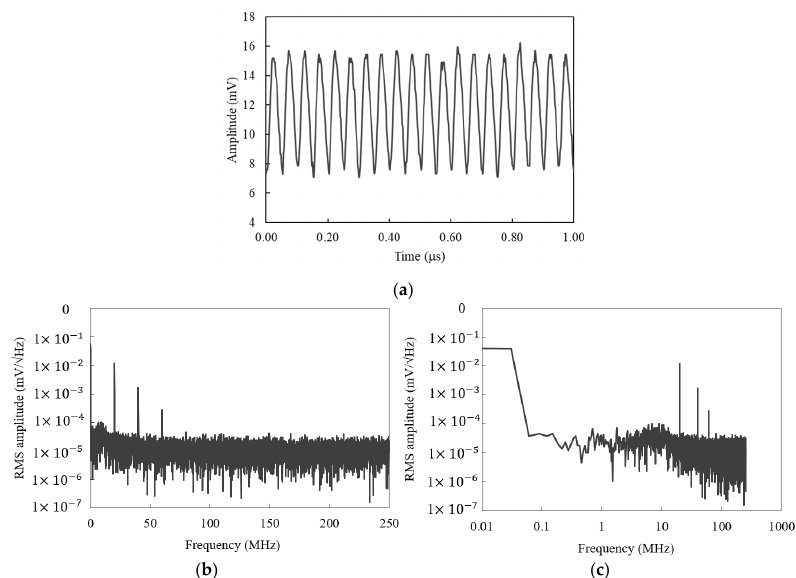
Figure 4. Modulation signal of the interferometer at f m = 20 MHz. ( a ) Sine waveform of the signal versus time, ( b ) and ( c ) FFT analysis of graph ( a ) with linear and logarithmic frequency axes, respectively.